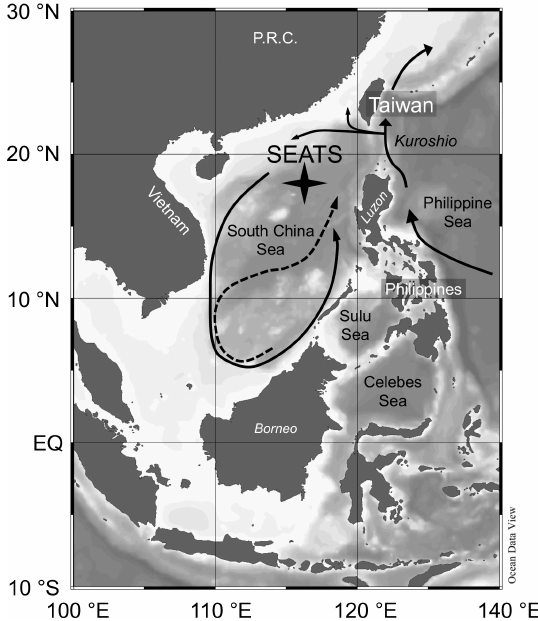
Figure 1. Bathymetric map of South China Sea (SCS) and sur- rounding areas with position of the SouthEast Asian Time-series Study (station 55, SEATS) indicated. Arrows in the SCS indicate the circulation patterns – solid line shows the basin-wide cyclonic gyre during winter; dashed line represents the eastward jet off the Vietnam coast and the anticyclonic gyre over the southern half of the SCS throughout the summer. Map was created using Ocean Data View (https://odv.awi.de/, Schlitzer,